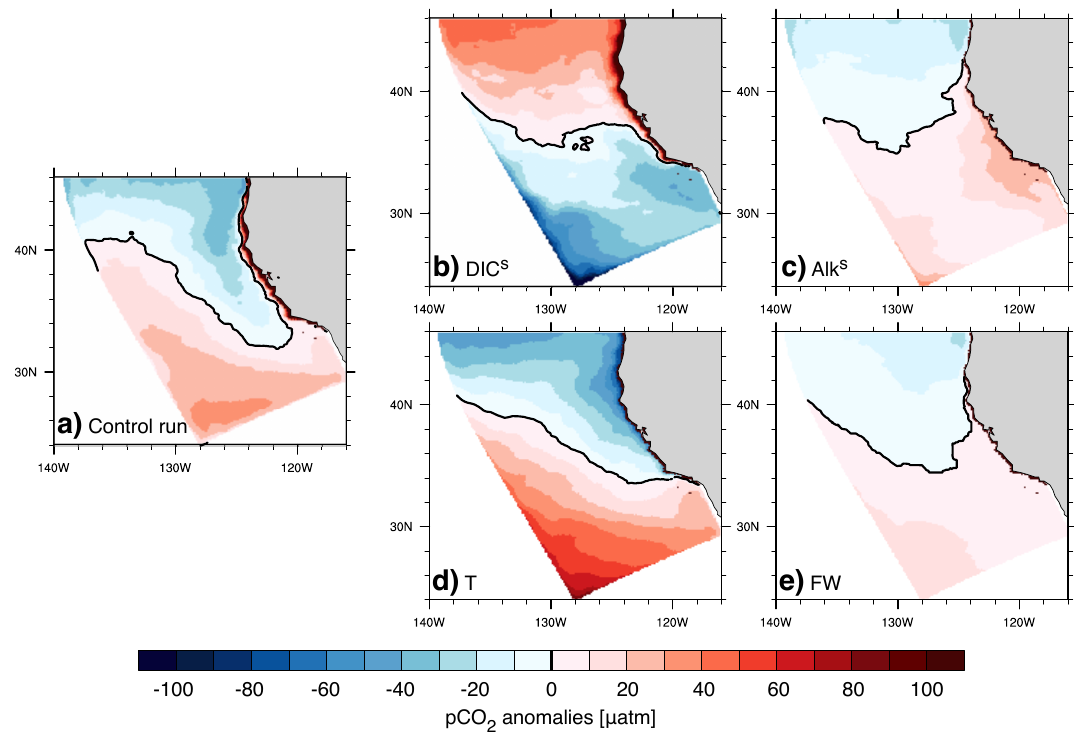
Fig. 6. Spatial p CO 2 anomalies computed as the difference between in situ and domain mean p CO 2 . Panel (a) shows total p CO 2 anomalies in the control simulation and panels (b–e) show the contributions of the four drivers DIC s , Alk s , T and FW to the